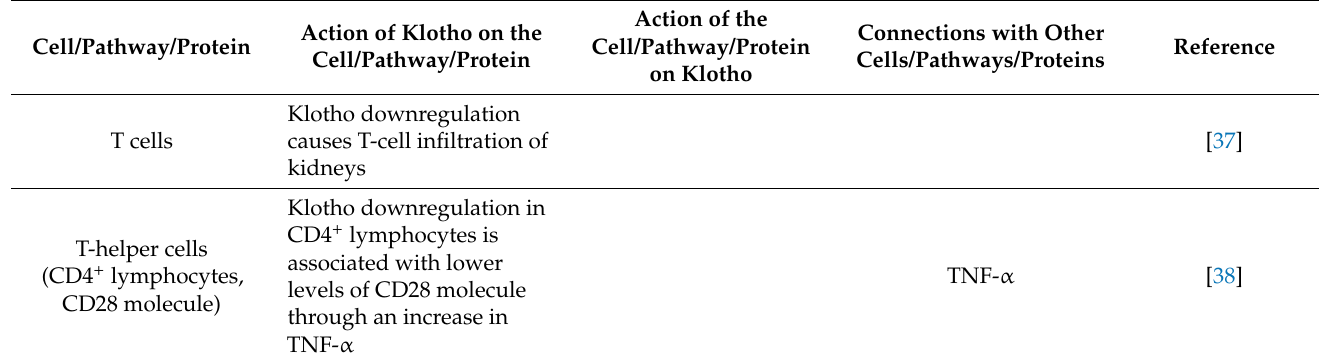
Table 1. Actions of Klotho on various cells, pathways, and proteins that are involved in inflammatory and fibrotic processes in diabetes and diabetic nephropathy, with their reciprocal actions on the Klotho protein.